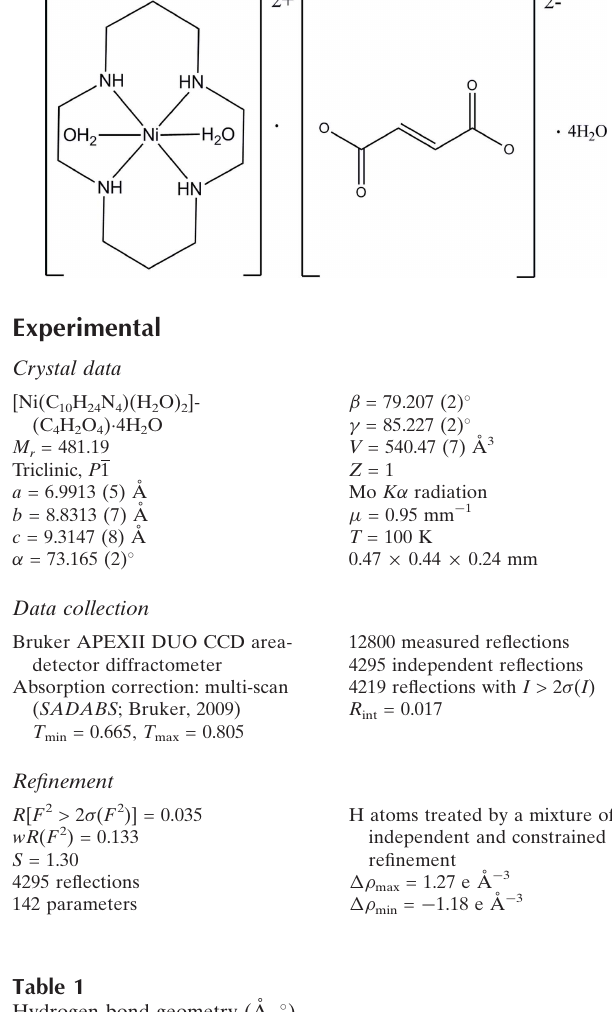
Hydrogen-bond geometry (A˚ , (cid:3)